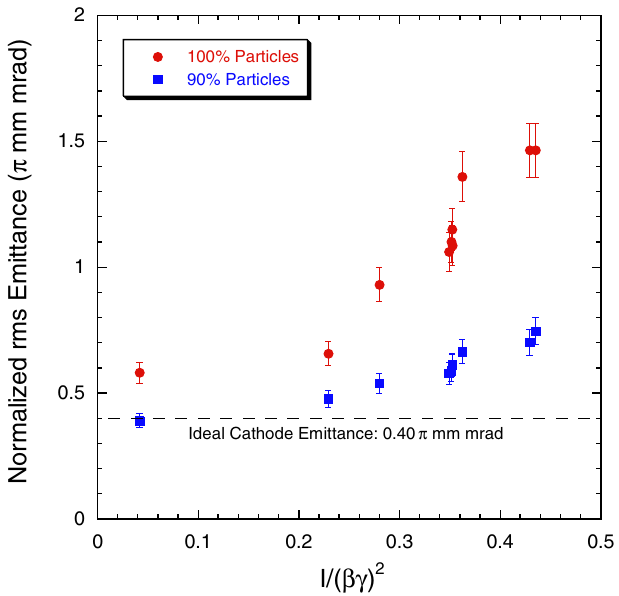
FIG. 13. (Color) Emittance growth as a function of normalized current, I= (cid:10) (cid:5)(cid:6) (cid:11) 2 .